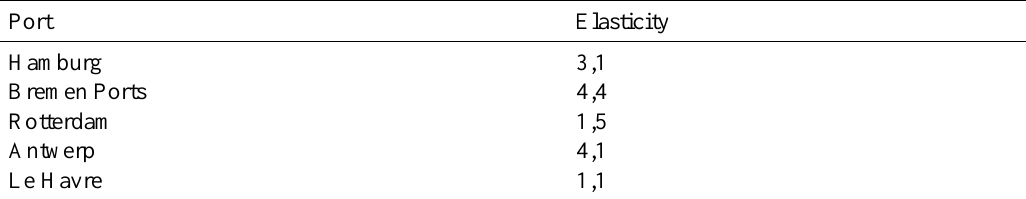
Table 3. Price elasticities for selected North Range container ports (10% price increase, simulation